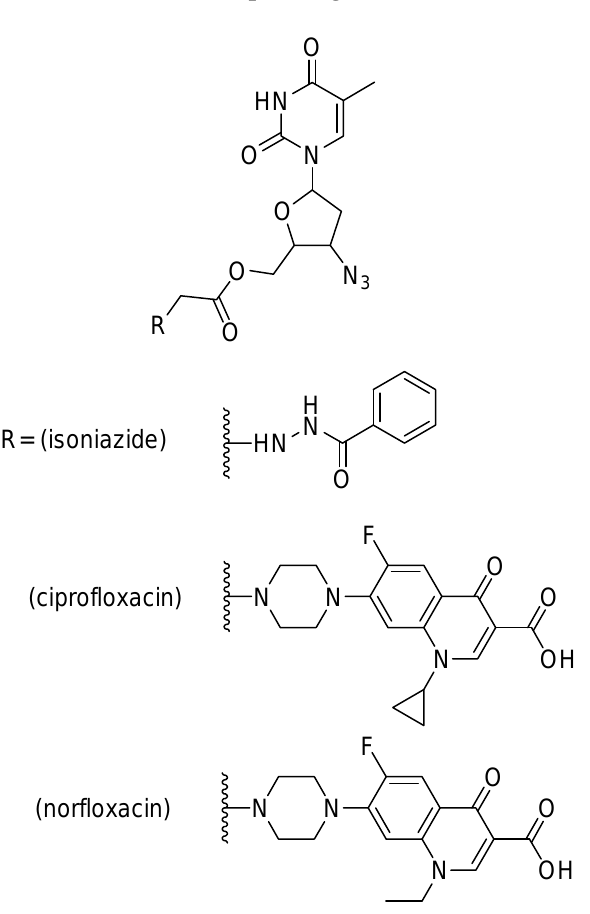
Figure 37. Ester prodrugs of